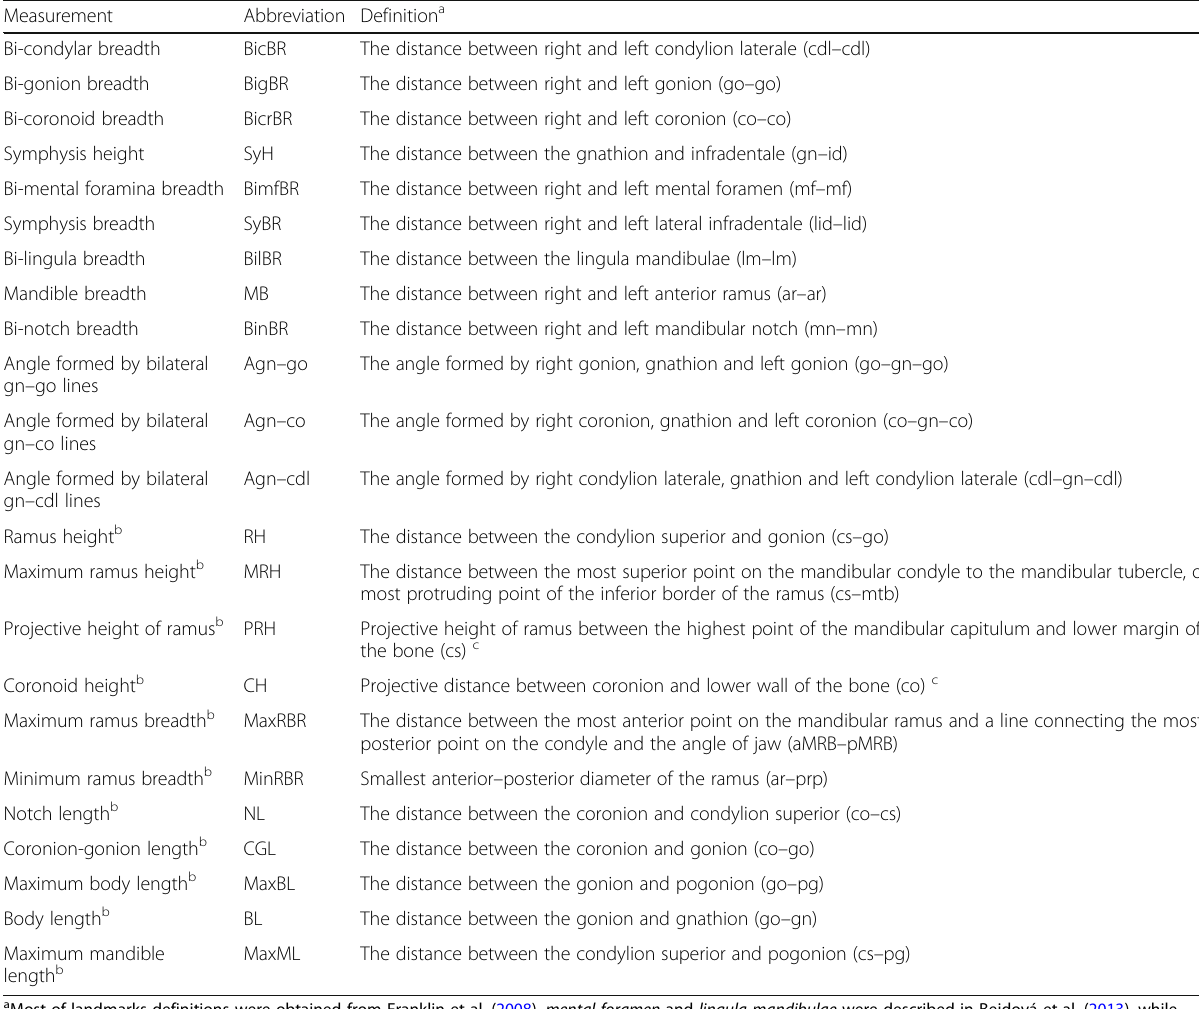
Table 1 Definitions of the measurements used in this